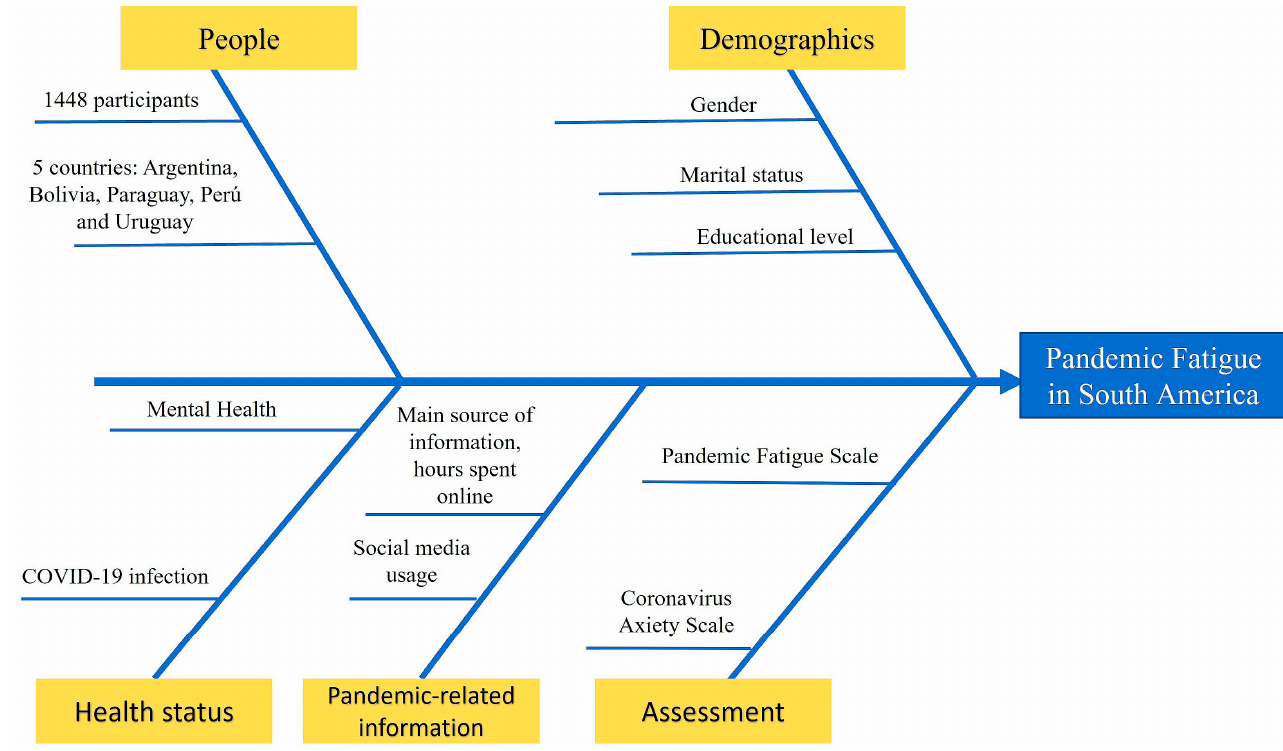
Figure 1. Ishikawa (fishbone) diagram of the methods.